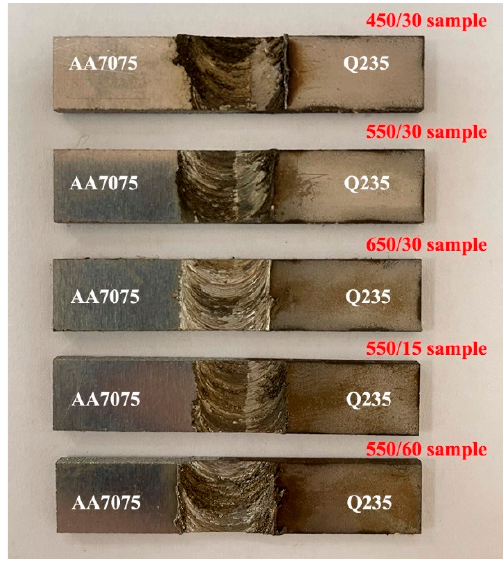
Figure 3. The top views of the FSW joints in this work.